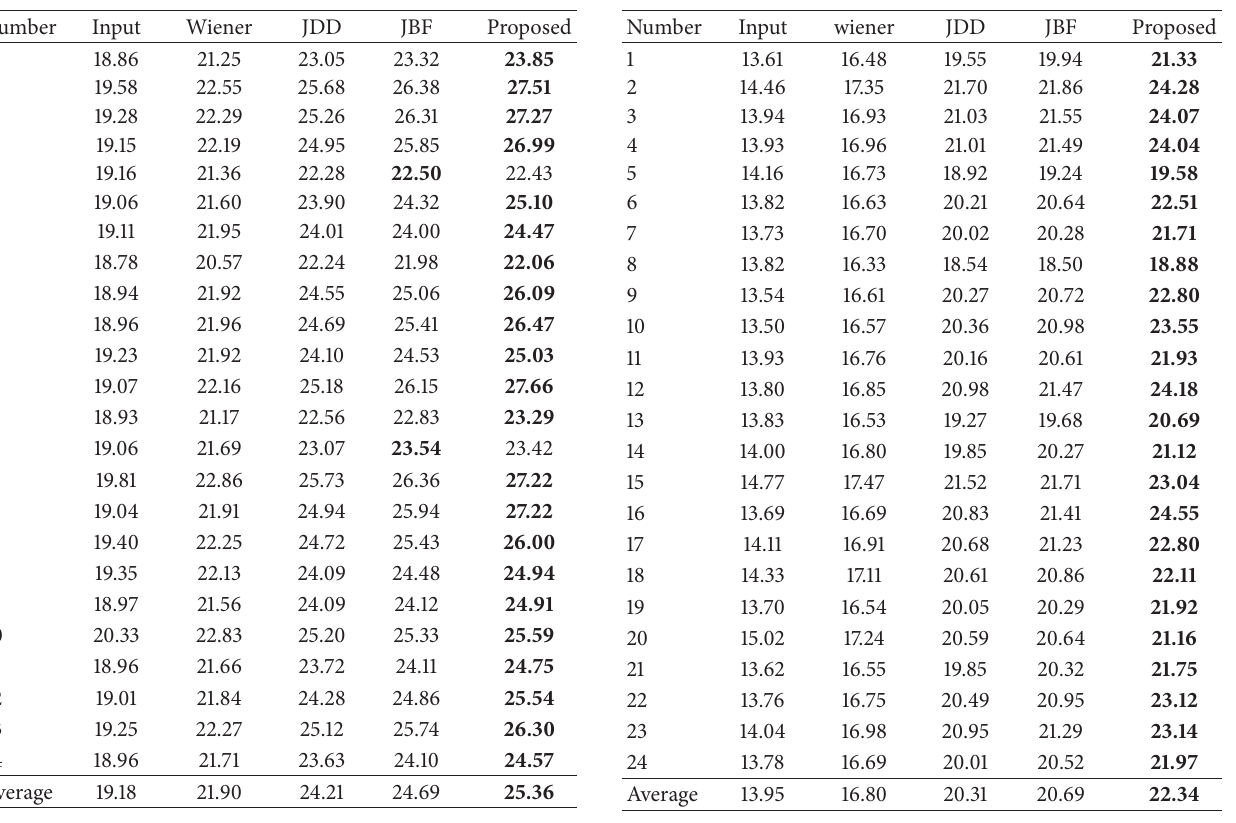
Table 2: CPSNR (DB) comparison result with noise 𝜎 𝑛 = 30 . Table 3: CPSNR (DB) comparison result with noise 𝜎 𝑛 = 60